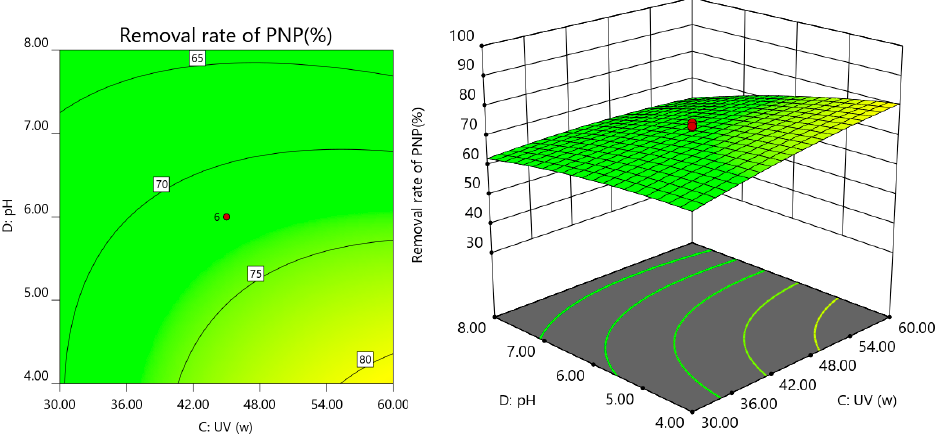
Figure 10. Response surface of the interaction between UV power and pH.